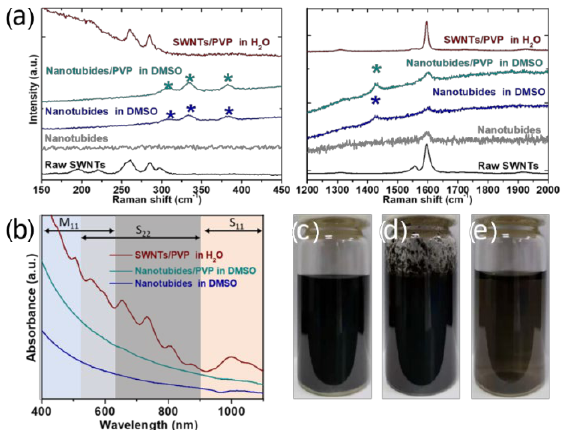
Figure 1. ( a ) Raman spectra of SWNTs at different stages, taken with a 633 nm laser excitation. The bands marked with * come from DMSO. From the bottom to the top are the raw SWNTs, nanotubides, nanotubides in DMSO, nanotubides/PVP in DMSO, and SWNTs/PVP in water. ( b ) UV– vis–NIR absorption spectra of SWNTs/PVP in H 2 O, nanotubides/PVP in DMSO, and nanotubides in DMSO. Photographs of nanotubide dispersion in DMSO before ( c ) and after ( d ) being exposed to air. ( e ) Photograph of neutralized nanotubide/PVP aqueous